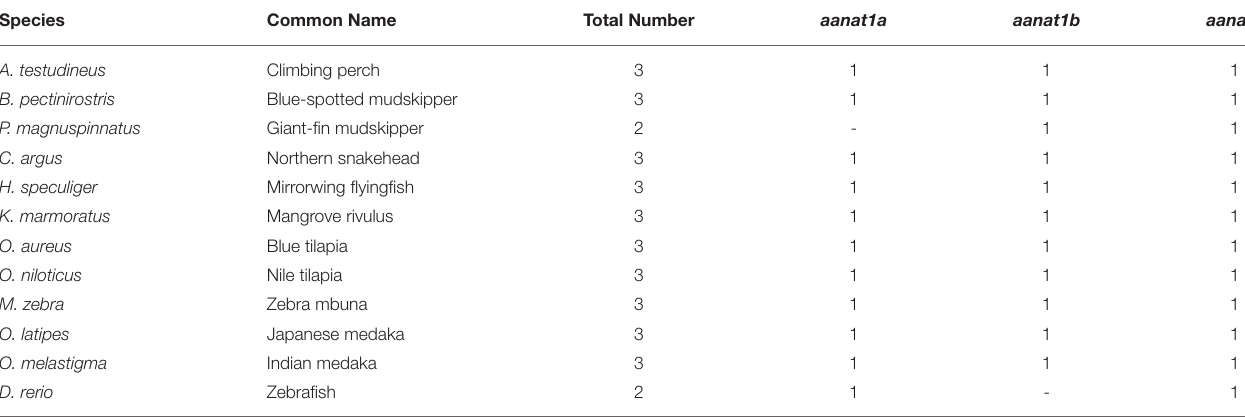
TABLE 4 | Copy number of aanat genes in the 12 representative teleost fishes.